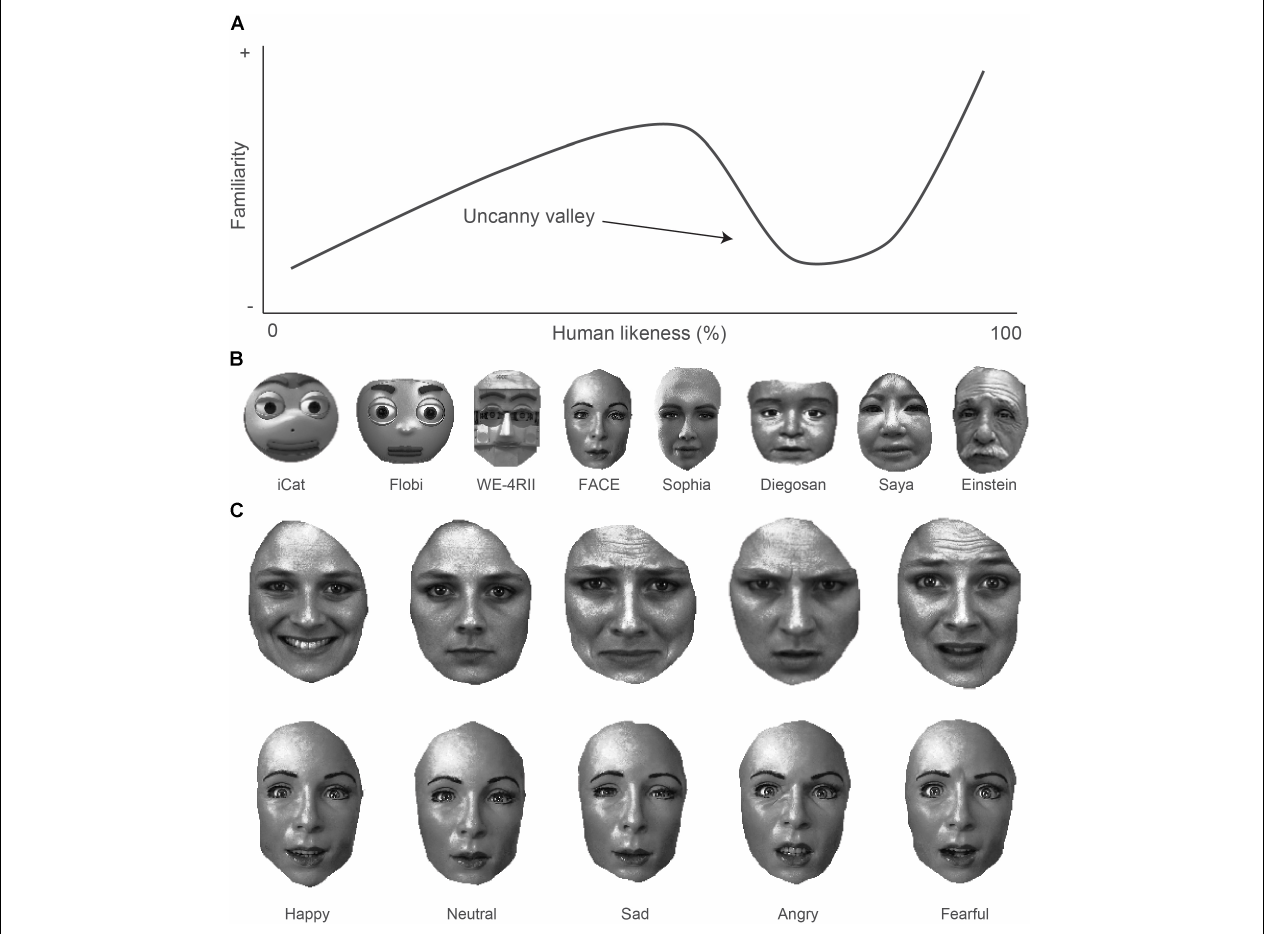
FIGURE 1 | The uncanny valley and stimuli. (A) Feeling of familiarity (canniness) as a function of human likeness of robots (Mori, 1970). The dip in the non-linear function indicates the uncanny valley. (B) Robot faces ordered along the dimension of human likeness. (C) Example of emotional expressions by a human (top row) and FACE robot character (bottom